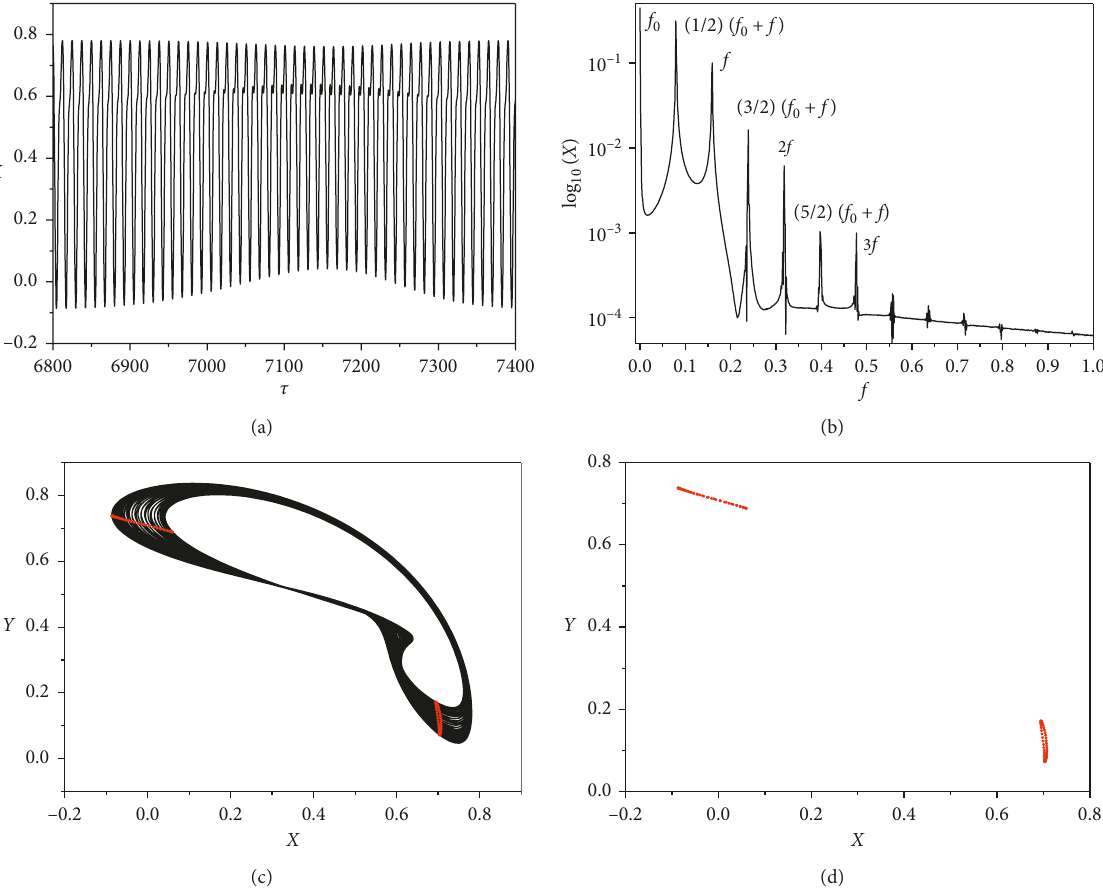
Figure 5: (a) Displacement. (b) Frequency response. (c) Rotor orbit. (d) Poincar´e map where